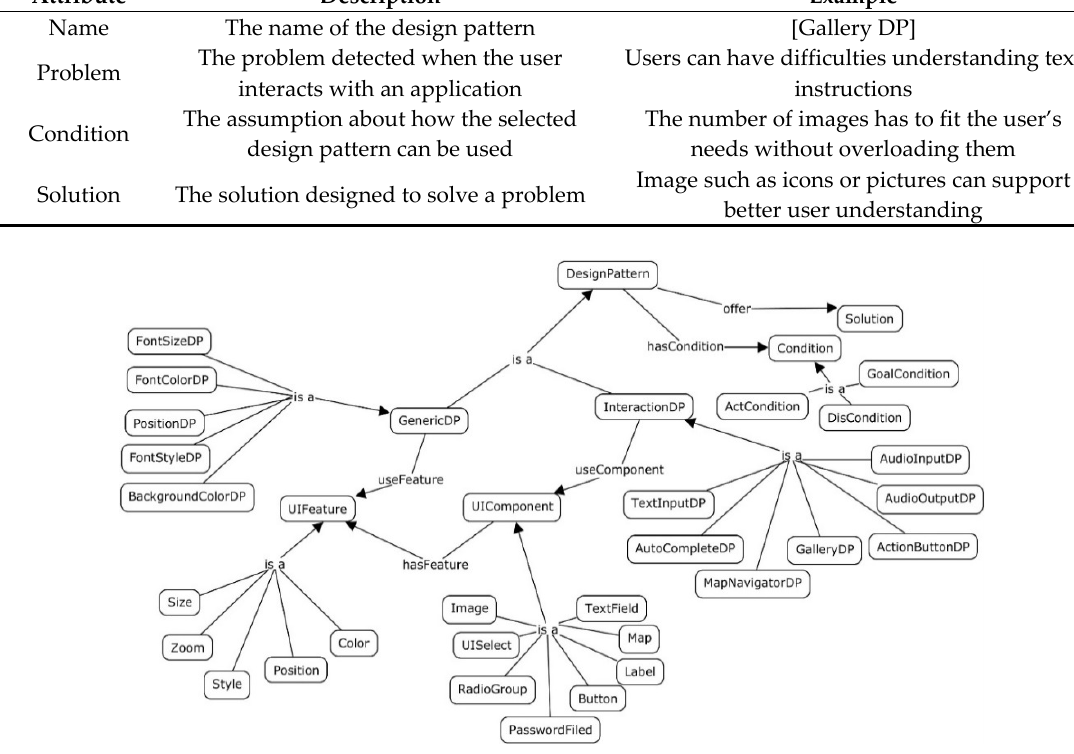
Figure 1. UI design pattern ontological